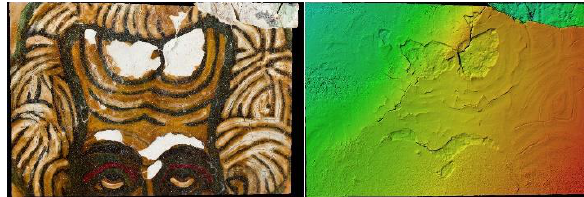
Figure 11. St. Nicholas, selected area for macro photogrammetry. Left: textured 3D model. Right: